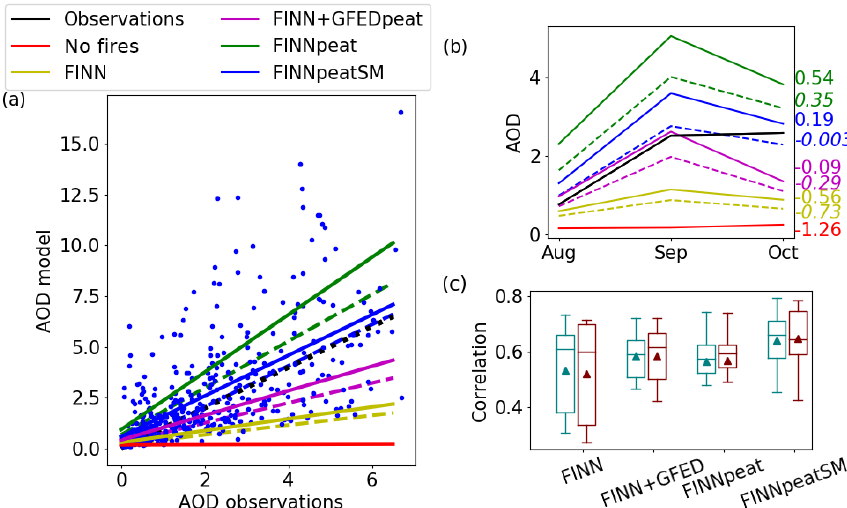
Figure 6. Comparison of simulated and observed AOD during August–October 2015, from eight AERONET sites in Indonesia, Singapore and Malaysia. Observed AOD is at 500nm and simulated AOD is at 550 nm. Panels (a) , (b) and (c) are the same as in Fig. 5 but for AOD. ary layer), as does the model with FINN+GFED emissions between simulated and measured AOD are highest for sim- (FB = − 0 . 09 and − 0 . 29). FINNpeat overestimates for both ulations with FINNpeatSM ( r = 0 . 64 with surface and 0.65 injection options (FB = 0.54 and 0.35), and FINNpeatSM with BL injection) followed by FINN+GFEDpeat ( r = 0 . 58 gives the lowest FB of − 0 . 003 with boundary layer injec- and 0.59), FINNpeat ( r = 0 . 57 for both injections) and FINN tion (0.19 with surface injection). The correlation coefficients ( r = 0 . 53 and 0.52). The AOD simulated by the model